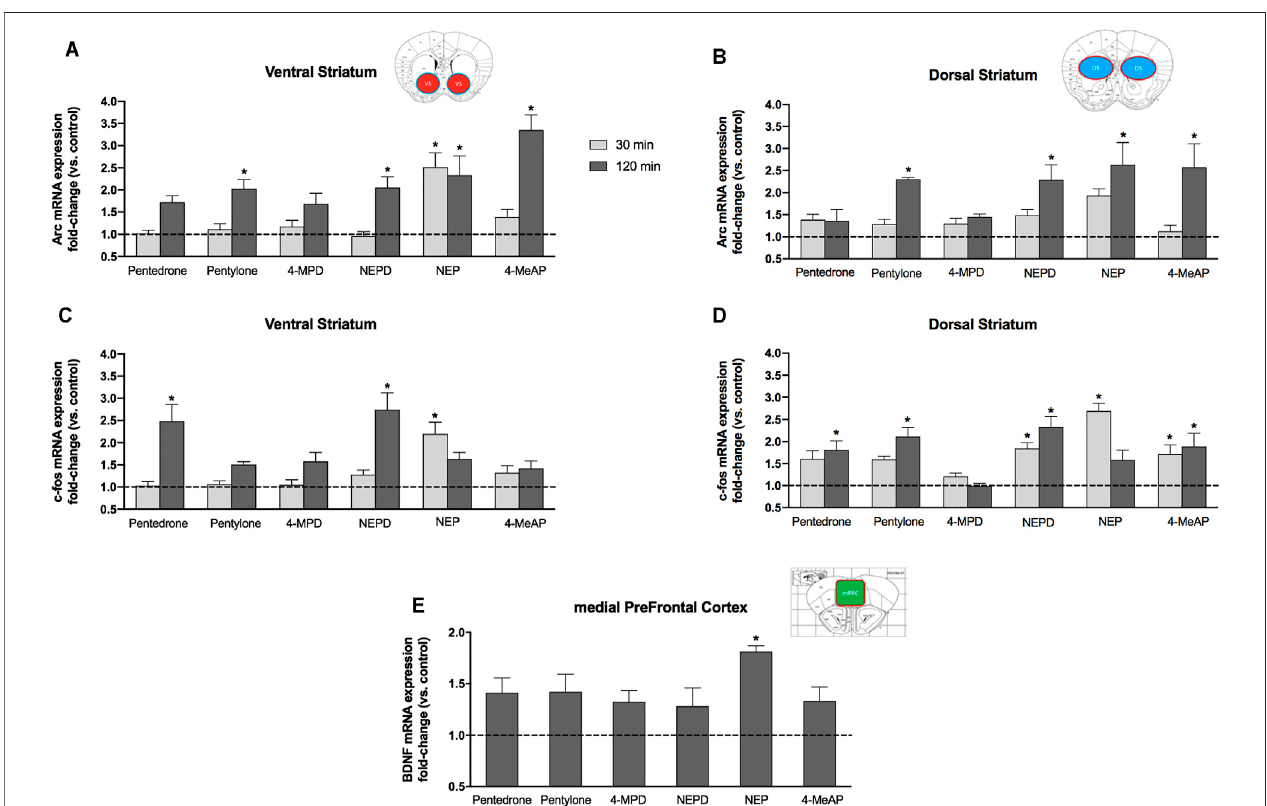
FIGURE 7 | Effects on Arc (A,B) and c-fos (C,D) mRNA expressions induced by a single acute dose (10 mg/kg, i.p.) of pentedrone, pentylone, 4-MPD, NEPD, NEP, and 4-MeAP in the mouse VS (A,C) and DS (B,D) at 30 and 120 min after administration. (E) Effects on bdnf mRNA expression induced by a single acute dose (10 mg/kg,i.p.)ofpentedrone,pentylone,4-MPD,NEPD,NEP,and4-MeAPinthemousemPFCat120 minafteradministration.Dataareexpressedasthemean ± SEM of fold changes in mRNA levels vs the corresponding saline group ( N (cid:2) 5 – 6 mice/group). Samples were tested in duplicate. Dunnett ’ s multiple-comparisons test; * p < 0.05 vs the corresponding saline group (30 or 120